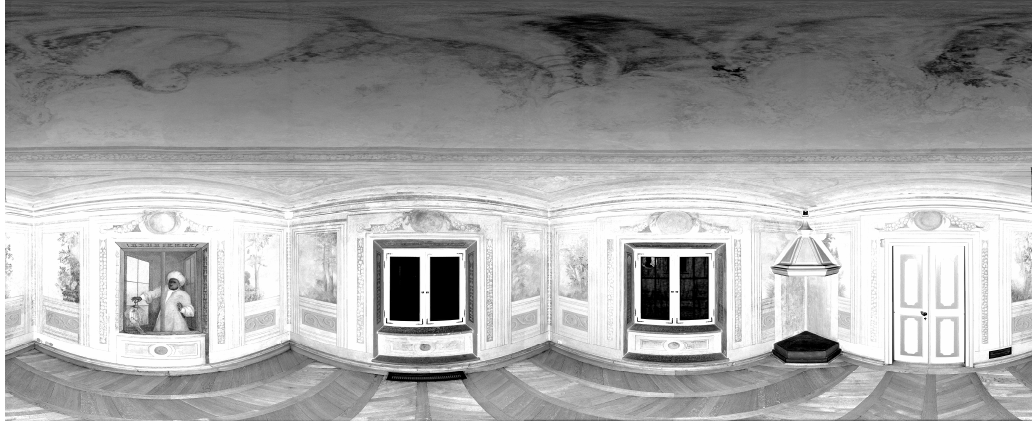
Figure 6. The point cloud in the spherical projection of test site II: “The Chamber with a Parrot” without marked points.